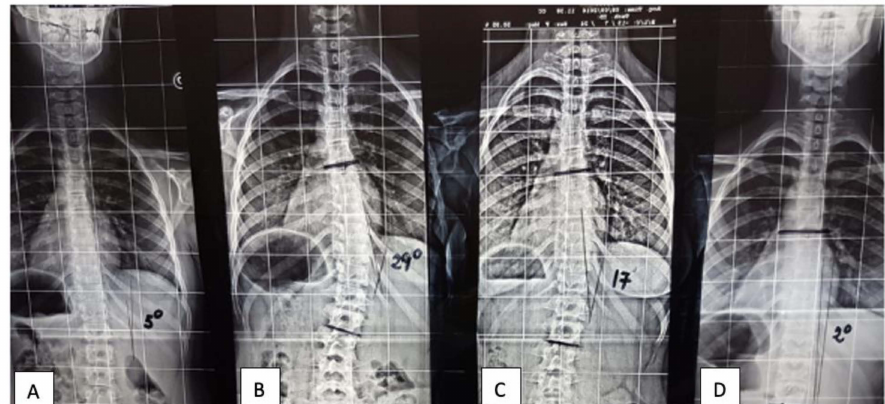
Figure 2. X-ray of the spine of a patient before and after rapid expansion of the palatal suture (RPE). ( A ) Cobb 5 ◦ Risser 0%. Without appliance. ( B ) Cobb 29 ◦ Risser 20%. 6 months after RPE device application. ( C ) Cobb 17 ◦ Risser 40%. 6 months after the removal of RPE device. ( D ) Cobb 2 ◦ Risser 60%. 12 months after the removal of RPE